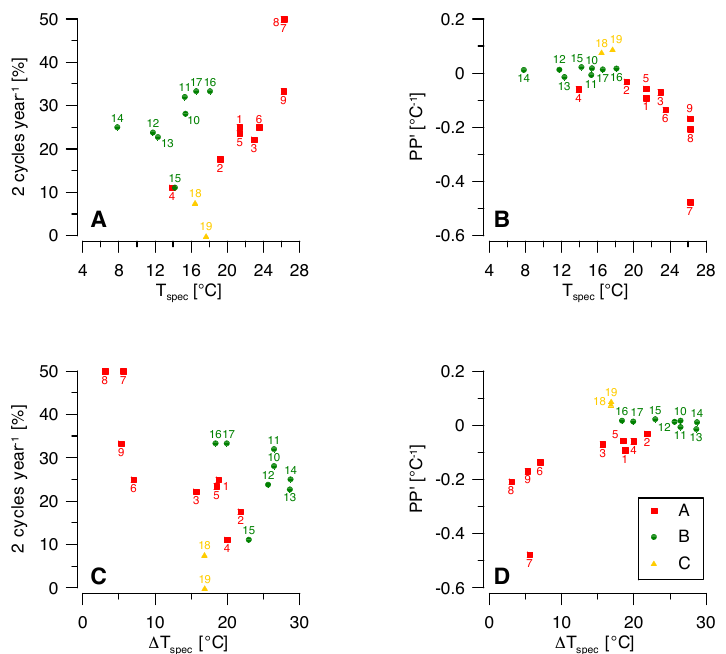
Figure 6. Scatter plots of the proportion of time series with two cycles per year (a) and temperature sensitivity of peak prominence (PP’) (b) vs. temperature averaged over all sites where a species was observed ( T spec ) . Panels (c) and (d) are arranged in the same way as (a) and (b) , but vs. temperature range ( (cid:49)T spec ) . Individual species are numbered (see Table